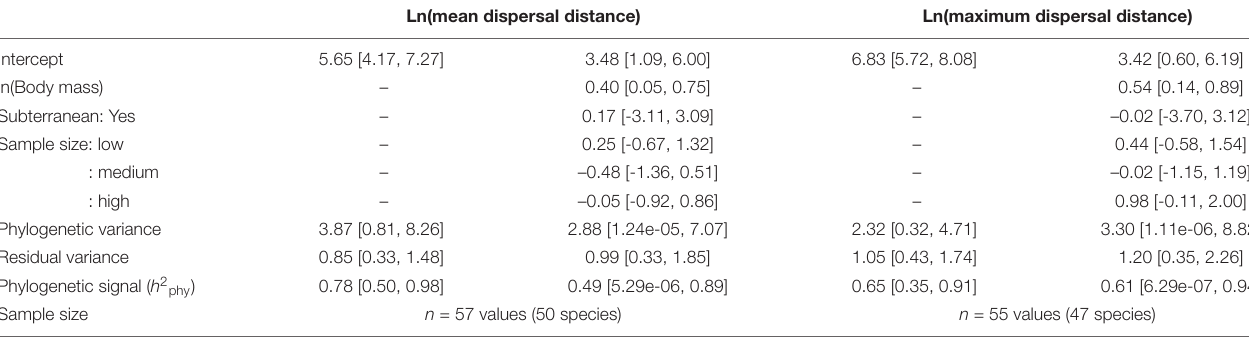
TABLE 1 | Results of Bayesian phylogenetic mixed models fitted to comparative data on rodent